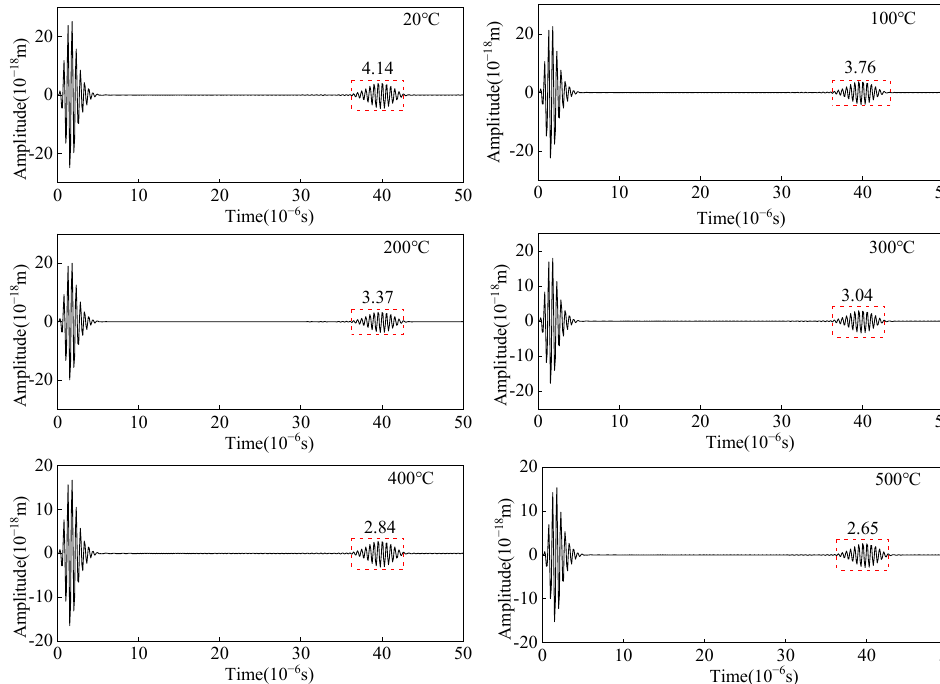
Figure 7. Excitation ultrasonic wave signal from the angled SV wave EMAT at different temperatures.